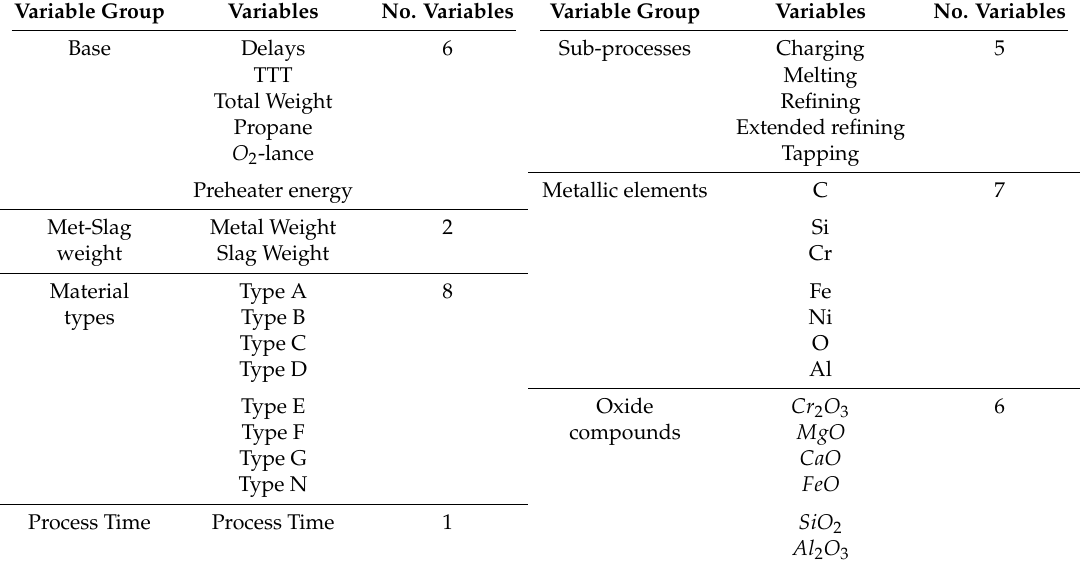
Table 5. Input variables for each variable group. The metallic elements and oxide compounds are the composition of the total charged metallic material and oxide bearing raw material,